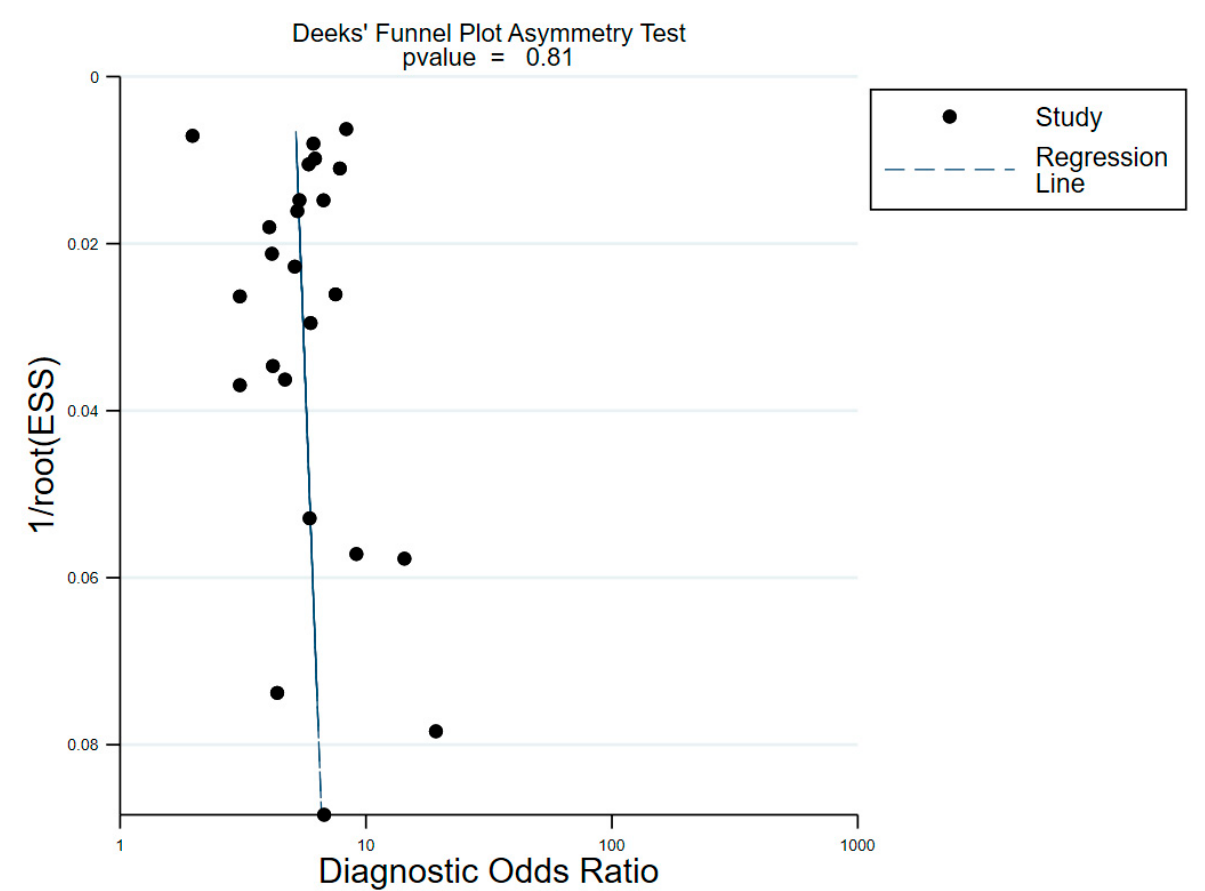
Figure 3. Deek’ funnel plot asymmertry test for assessing publication bias in the included studies with superimposed regression.